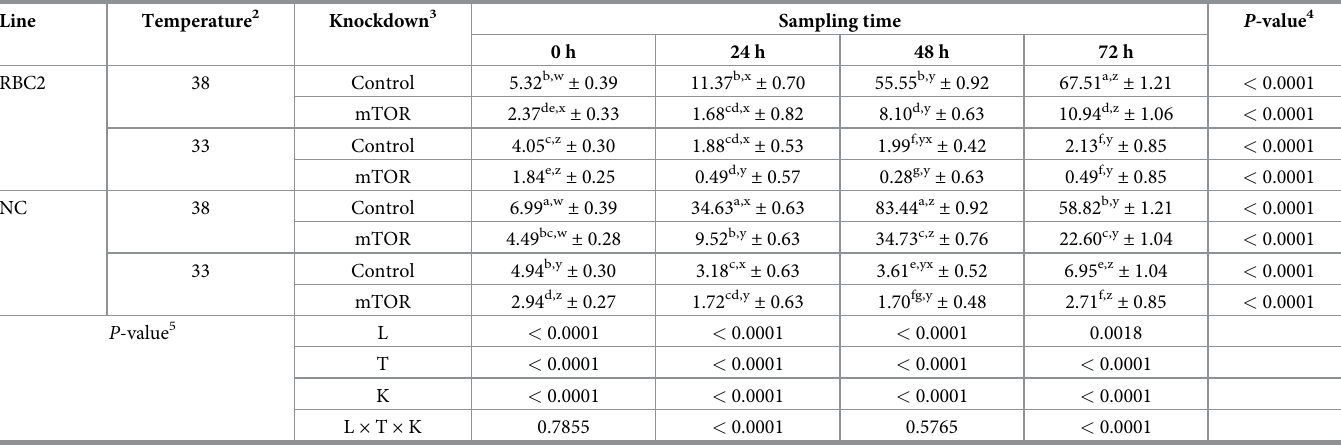
Table 6. Effect of cold stress (33˚C) and knockdown of mTOR at the beginning of proliferation on differentiation of RBC2 and NC line SCs 1 .